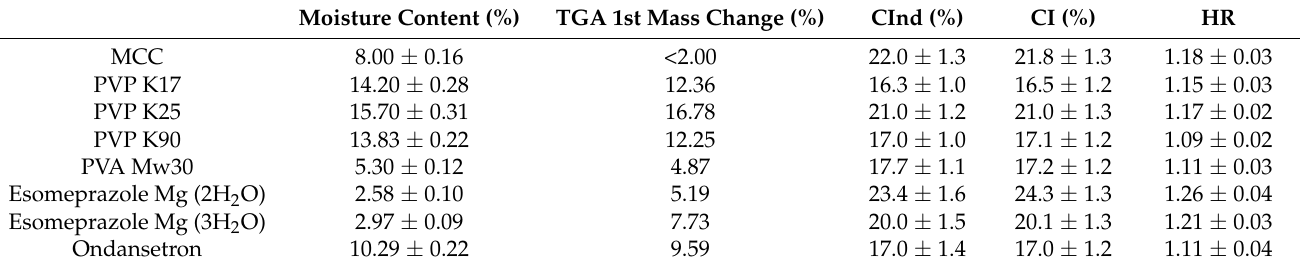
Table 1. Results obtained for the moisture content (loss on drying and thermal analysis) and flowabil- ity